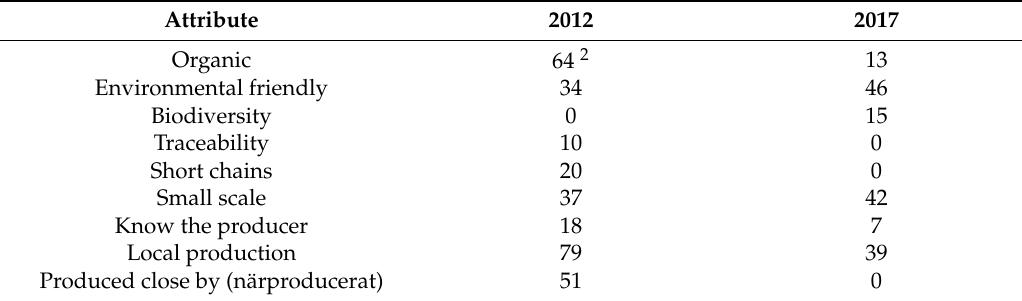
Table 3. The summary of post-modern and environmental attributes 1